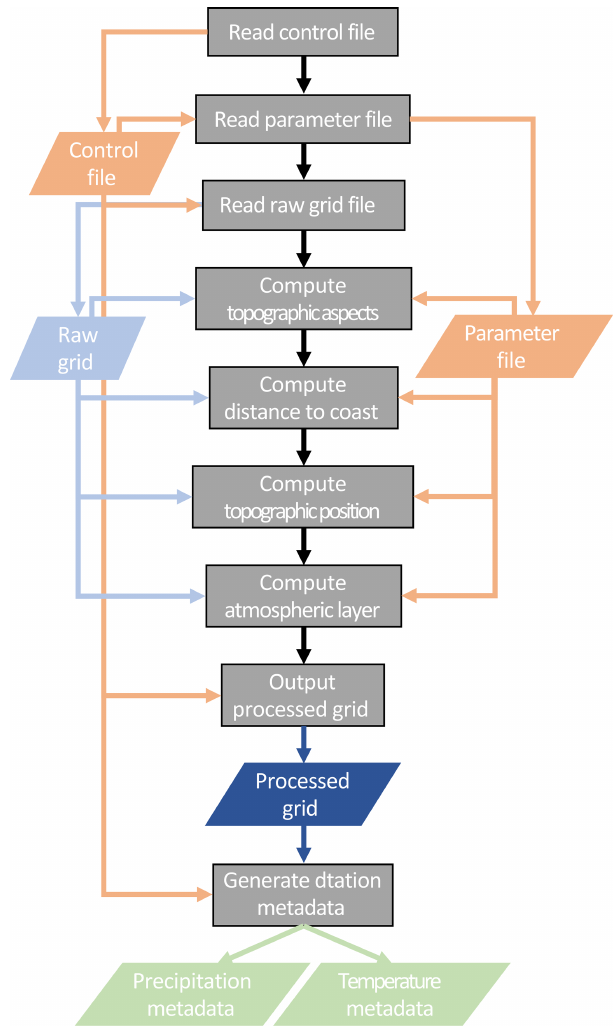
Figure 1. Flowchart describing the TIER pre-processing system. Processes are shaded gray, input files are orange, topographic inputs and outputs are shades of blue, and outputs are various shades of